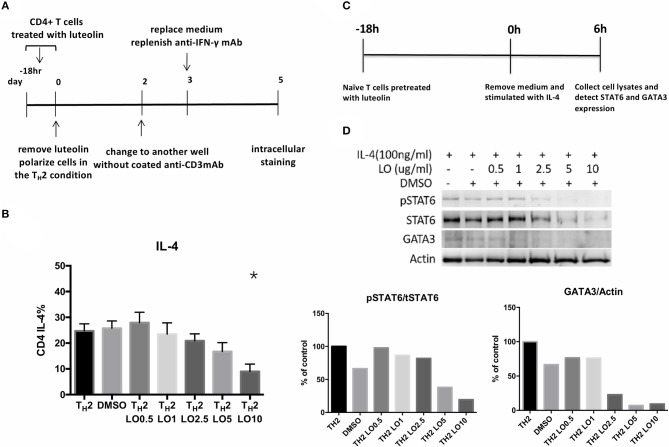
(A) Experimental protocols for evaluating the efficacy of luteolin on murine CD4+ cell polarization. (B) Pre-treatment of luteolin reduced the percentage of CD4+ IL-4-secreting cells. *P < 0.05 vs. TH2. (C) Experimental protocols for evaluating the efficacy of luteolin on murine naïve CD4+ cell polarization. (D) STAT6 and GATA3 protein expression of mouse naïve CD4+ cells were detected by western blot. pSTAT6 = phosphorylated (active) STAT6 protein; tSTAT6 = total STAT6 protein.